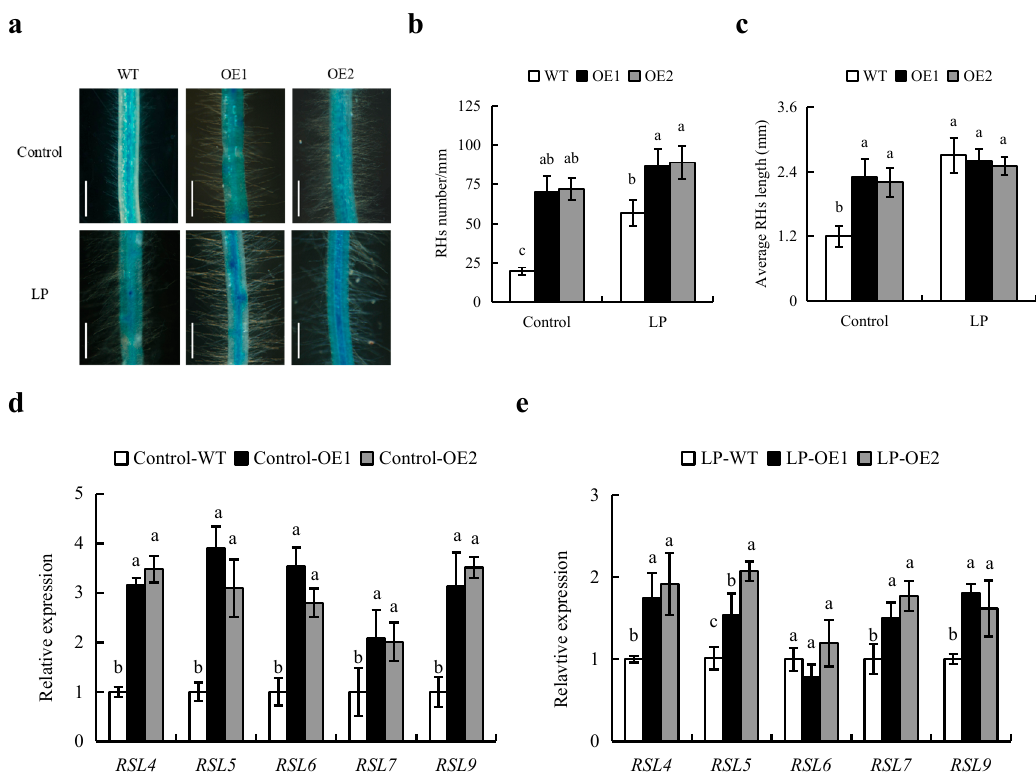
Figure 6. Root hairs (RHs) formation and qRT-PCR analysis of genes in wild type (WT, Nipponbare) and OsPIN2 overexpression lines (OE1 / OE2). Seedlings were grown in hydroponic media containing normal nutrition (control, 300 µ M P) or low P (LP, 10 µ M). ( a ) The morphology of RHs. ( b ) The density of RHs. ( c ) Average RHs length. Bar = 0.5mm. ( d , e ) The gene expression under normal nutrition ( d ) and low P; ( e ) for 6 h. Relative mRNA levels were normalised to OsACT . h = hours. Data are means ± SE and bars with di ff erent letters indicate significant di ff erences in the same gene ( p < 0.05, ANOVA). All experiments included three independent biological replicates.